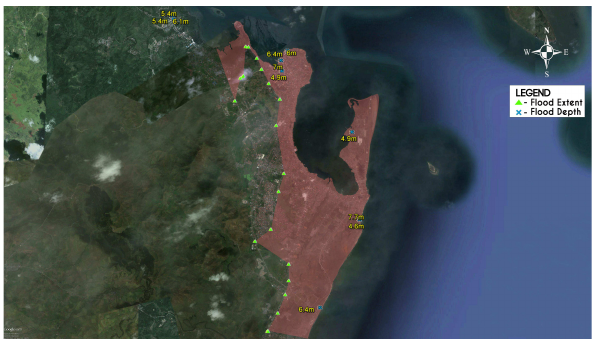
Figure 2. Results of the JSCE-PICE joint field survey.